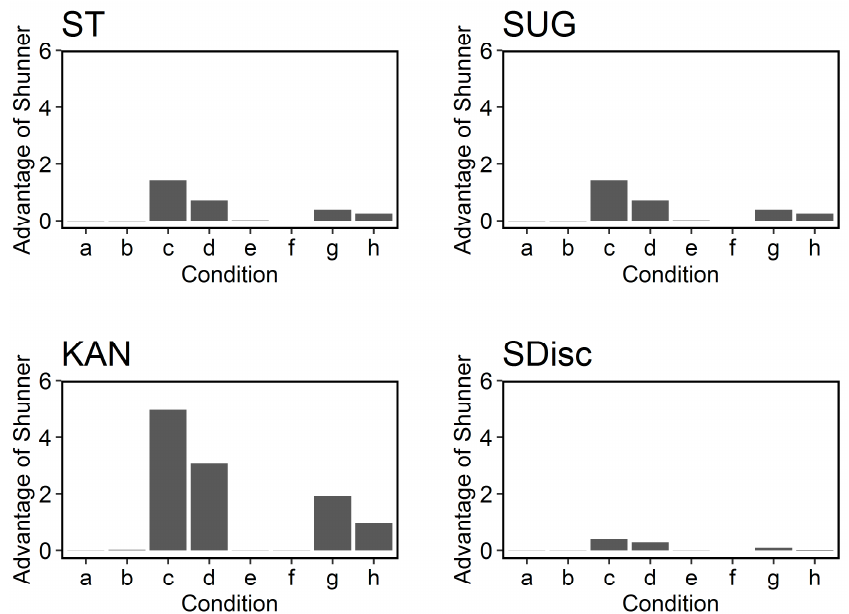
Figure 1. Difference between Shunners’ payoffs and Cooperating-Reciprocators’ payoffs. Shunners of standing, sugden and kandori had evolutionary advantage in simulations with SD and ISE errors (conditions c, d, g, h). The advantage was smaller when perception errors existed (comparing g and h to c and d). The advantage was also smaller when two-way errors existed (comparing condition d and h to c and g).